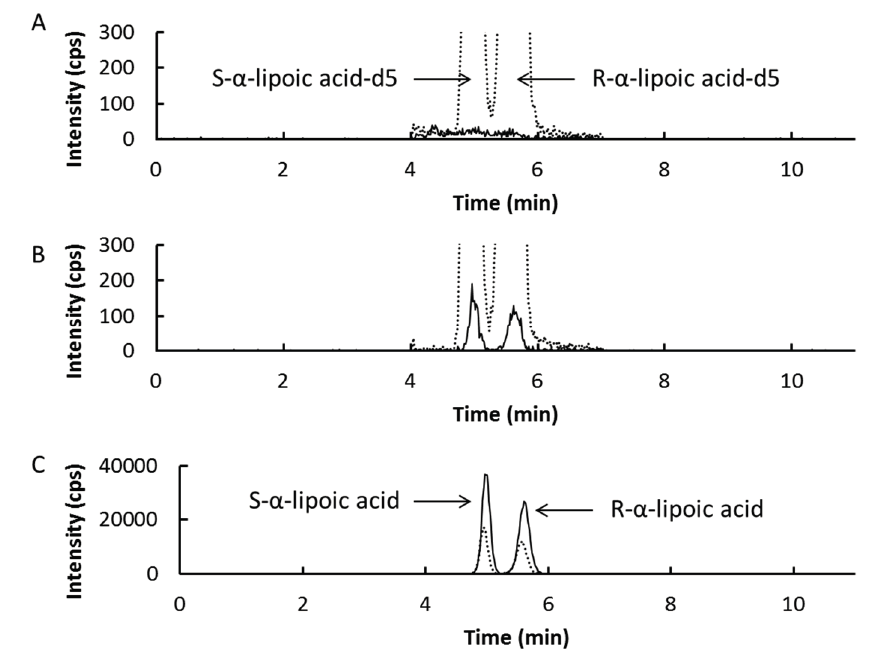
Figure 2. Representative chromatograms for α -lipoic acid chiral separation in plasma. Chromatograms shown with solid and dotted line are for α -lipoic acid and α -lipoic acid-d5 (internal standard), respectively. Blank plasma ( A ); blank plasma spiked with α -lipoic acid (5 ng of each enantiomer/mL, B ); and blank plasma spiked with α -lipoic acid (1250 ng of each enantiomer/mL, C